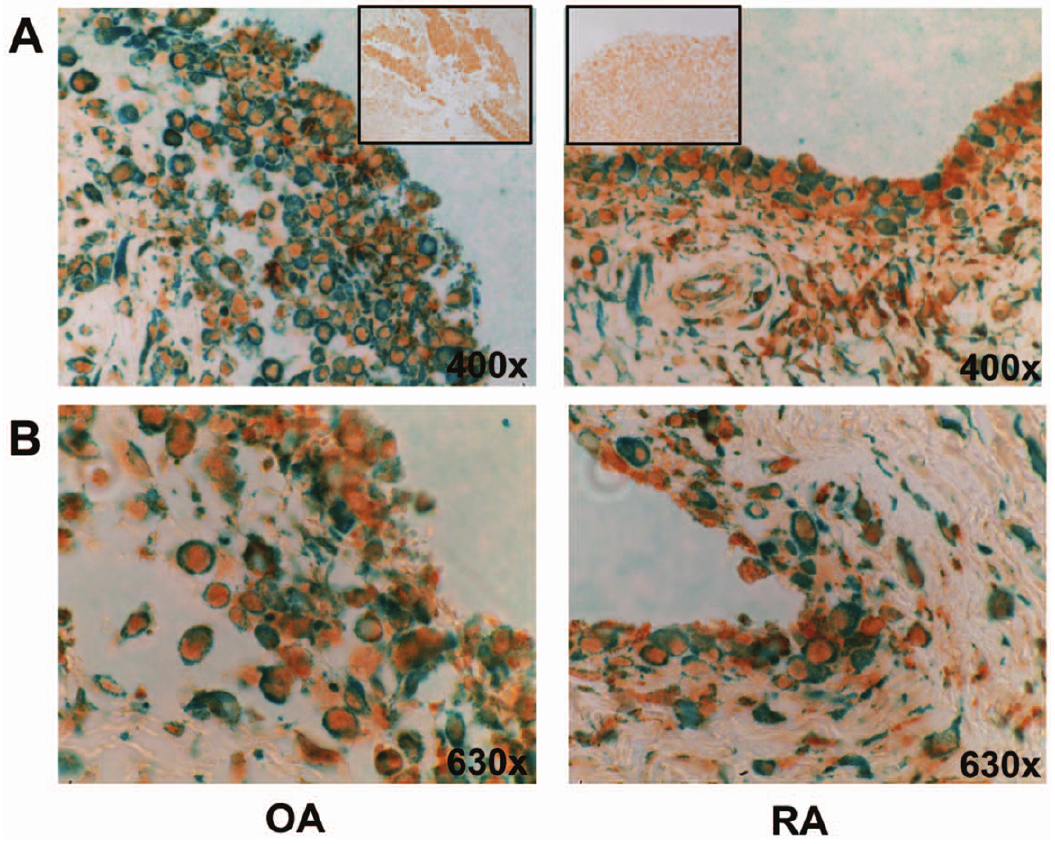
Figure 3. Immunohistochemistry. Representative photomicrographs showing immunohistochemical double staining of OA and RA synovial tissues with P2X4 (brown) and fibroblast marker (green). A . original magnification 400 6 , box shows the Isotype control, magnification 200 6 . B . original magnification 630 6 .